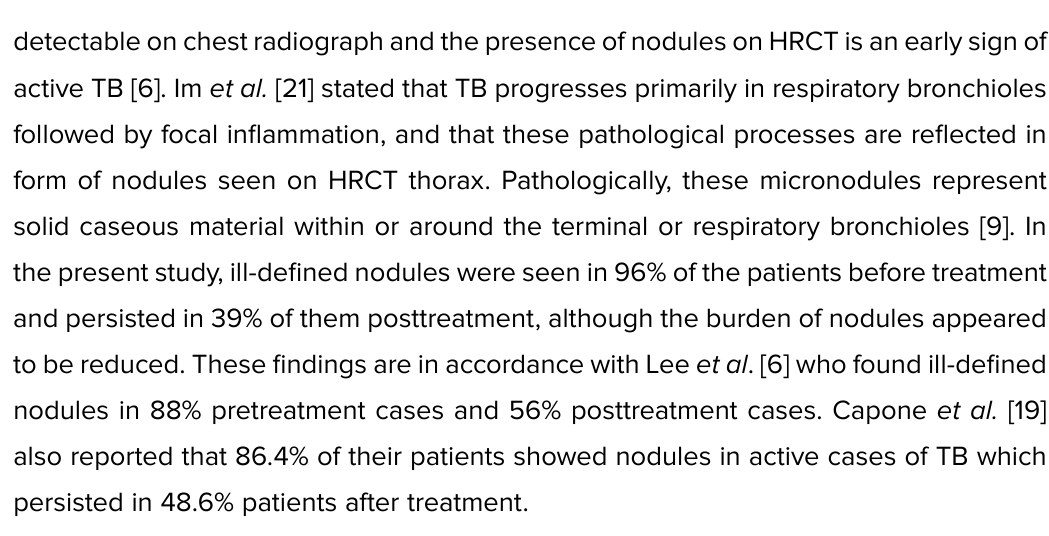
Figure 5 : Axial section of HRCT lung in a patient of tuberculosis at the level of apical segment of lung. (A) HRCT scan obtained at the time of diagnosis shows thick-walled cavity (white arrows) and micronodules (black arrow) on right side. (B) Follow-up HRCT scan obtained after six months of ATT shows cicatricial changes in form of fibrotic parenchymal band (black arrow). There is complete resolution of cavity and